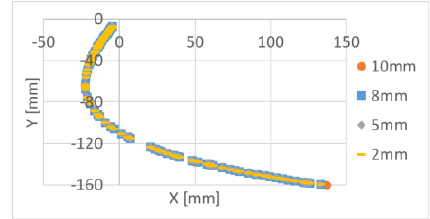
Fig. 5. Comparison of droplet trajectories for differently sized mesh